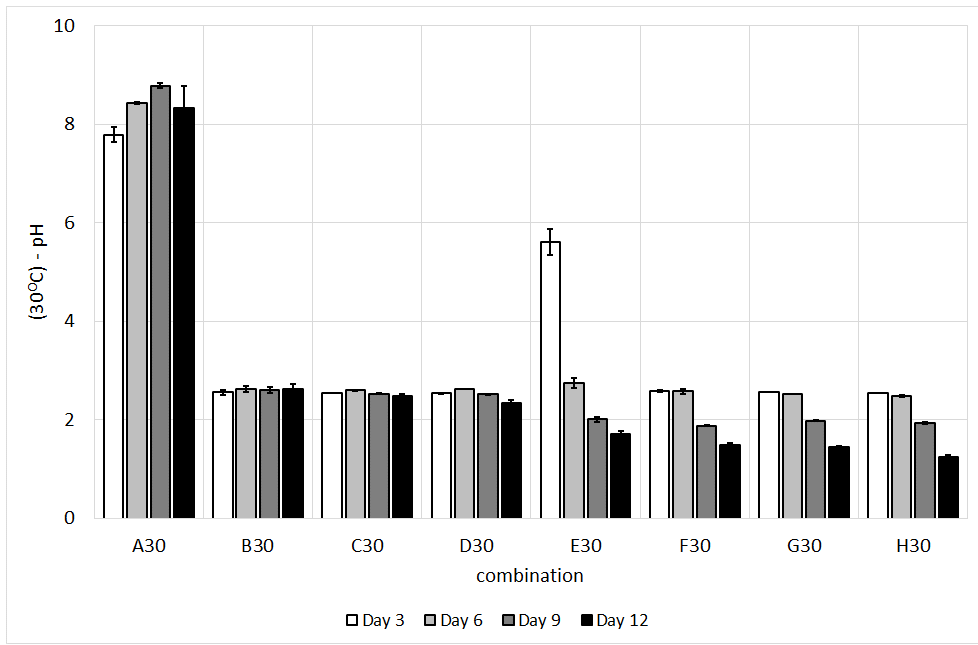
Figure 3. Changes in pH of bacteria culture samples incubated at 30 °C.